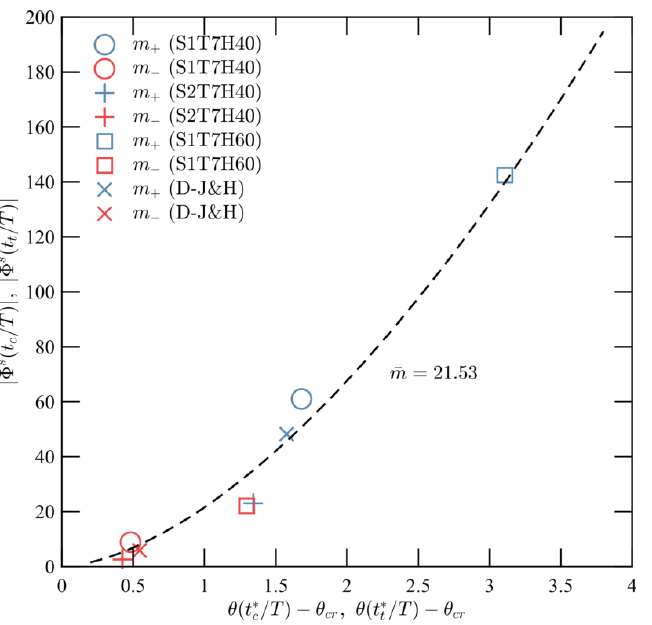
Figure 12. Dimensionless total sediment transport rate, Φ s , as a function of θ − θ cr , at wave crest (blue symbols, t = t c ) and trough (red symbols, t = t t ), for all four cases. The dashed curve represents the mean of m + and m − for all four cases ( ¯ m =